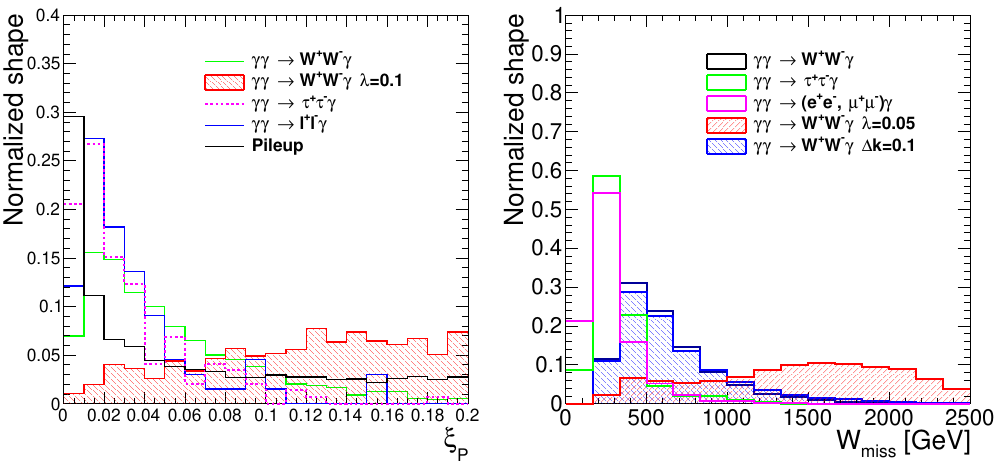
Figure 3 . Distribution of fractional energy loss of protons reaching the FDs (left) and protons missing mass (right) for SM pp ! p W + W (cid:0) (cid:13) p, pp ! p l + l (cid:0) (cid:13) p and two pp ! p W + W (cid:0) (cid:13) p samples including aTGCs correspond to (cid:21) (cid:13) = 0 : 05 and (cid:1) (cid:20) = 0 :